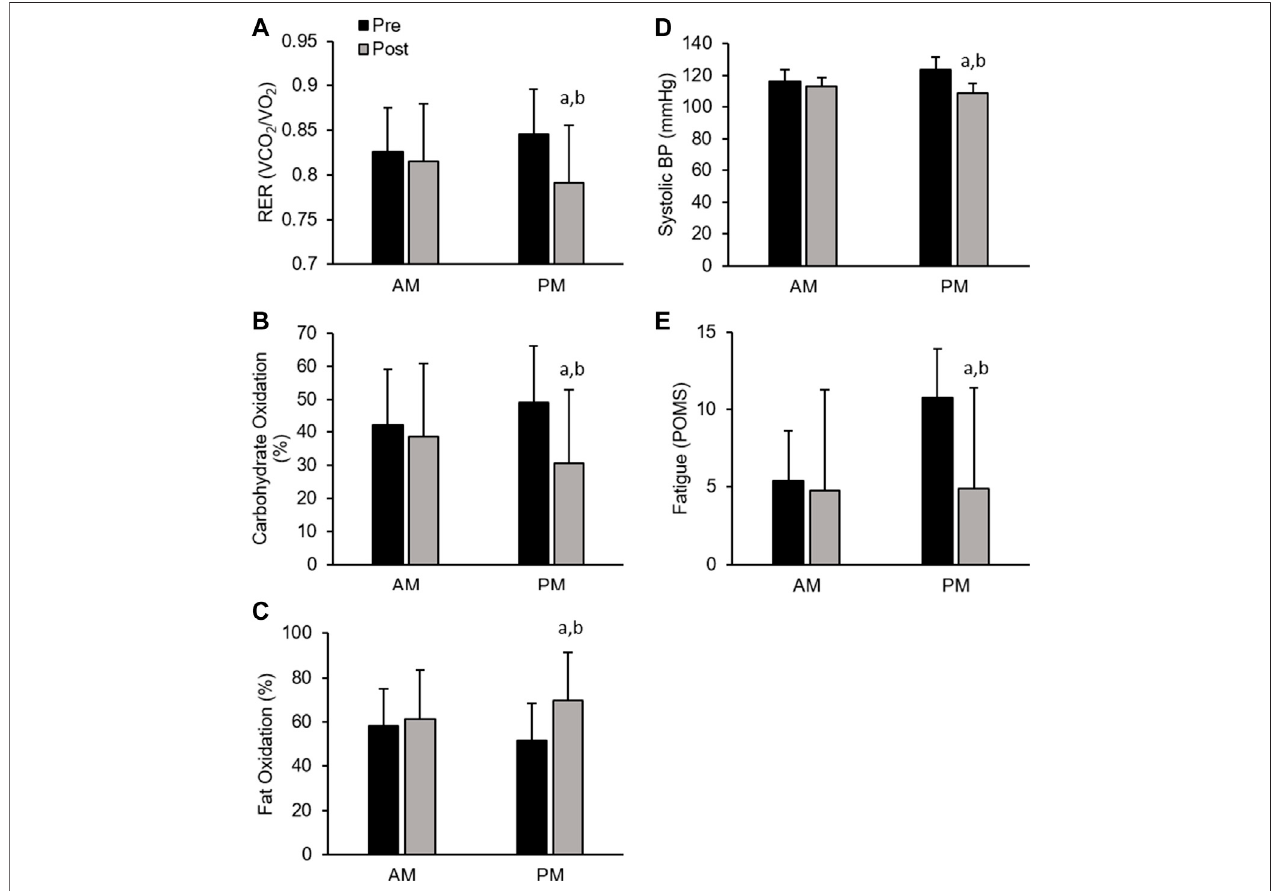
FIGURE 4 | Signi fi cant Changes in Men with RISE Exercise Training Conducted in the Morning (AM) or Evening (PM). Respiratory Exchange Ratio (RER, (A) , Relative CarbohydrateOxidation (%, (B) ,andRelativeFatOxidation (%, (C) ,SystolicBloodPressure (D) ,Fatigue(POMS, (E) . a p < 0.05prevspostpairwisedifferences; b p < 0.05 group × time interaction. Data are means ±